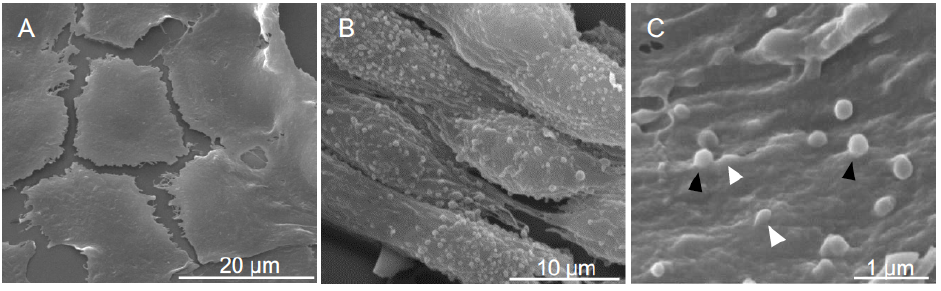
Figure 7. rApe is sufficient for adhesion of latex beads to bovine endothelial cells. Representative images of BAEC incubated 30 minutes with fluorescent latex beads (1.82x10 8 ) coated with rApe and processed for scanning electron microscopy. (A) Endothelial cells did not retain non-adsorbed beads (0.1µm diameter) on their cell surface. (B) On the opposite, the whole surface of the same type of cells are covered with adherent beads (0.5µm diameter) absorbed with rApe. (C) Enlarged view of adherent beads. Such beads present two kinds of localizations. Some of them are already internalized (black arrow heads) while others are still located outside the cell remaining in contact with the cytoplasmic membrane (white arrow heads). Scale bars are